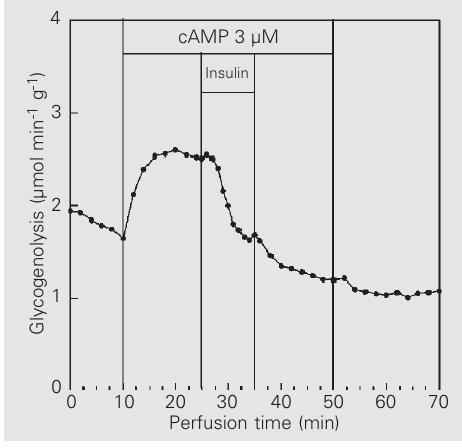
Figure 3. Effect of adenosine-3'- 5'-cyclic monophosphate (cAMP) (panels A and B) and dibutyryl cyclic AMP (DB-cAMP) (panels C and D) on glycogenolysis in the presence (lozenges) and ab- sence (squares) of insulin (500 µIU/ml). The data are reported as the means of 4-6 individual liver perfusion experiments. The area under the curve (AUC) data (µmol/g liver fresh weight ± SEM) are presented in the fig- ure. The statistical test used was the unpaired Student t